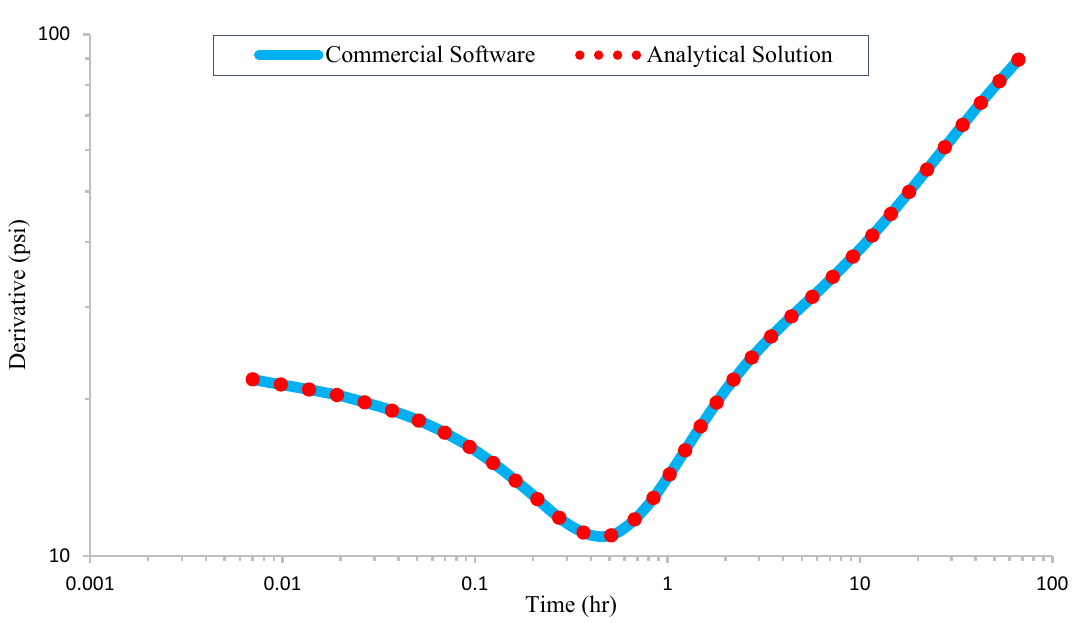
Fig. 16 Matching analytical and numerical pressure derivative plots in log–log scale of the scenario No. 6 in naturally fractured